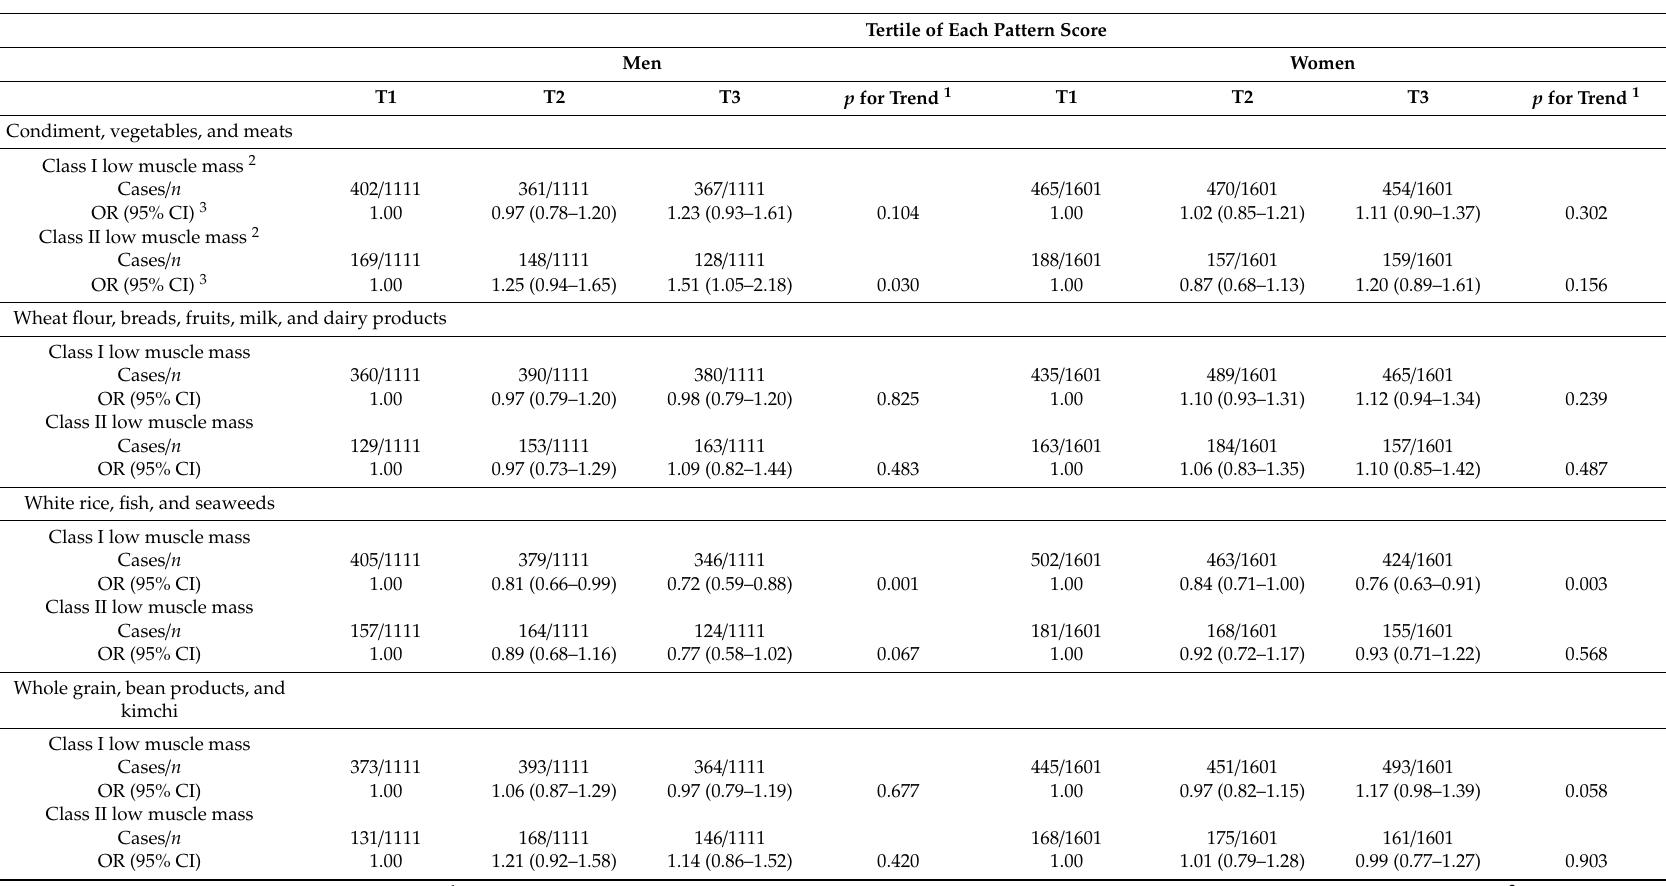
Table 3. Odds ratios and 95% confidence intervals for risk of low muscle mass according to the tertiles of each dietary pattern score by sex. Tertile of Each Pattern Score Men Women T1 p for Trend